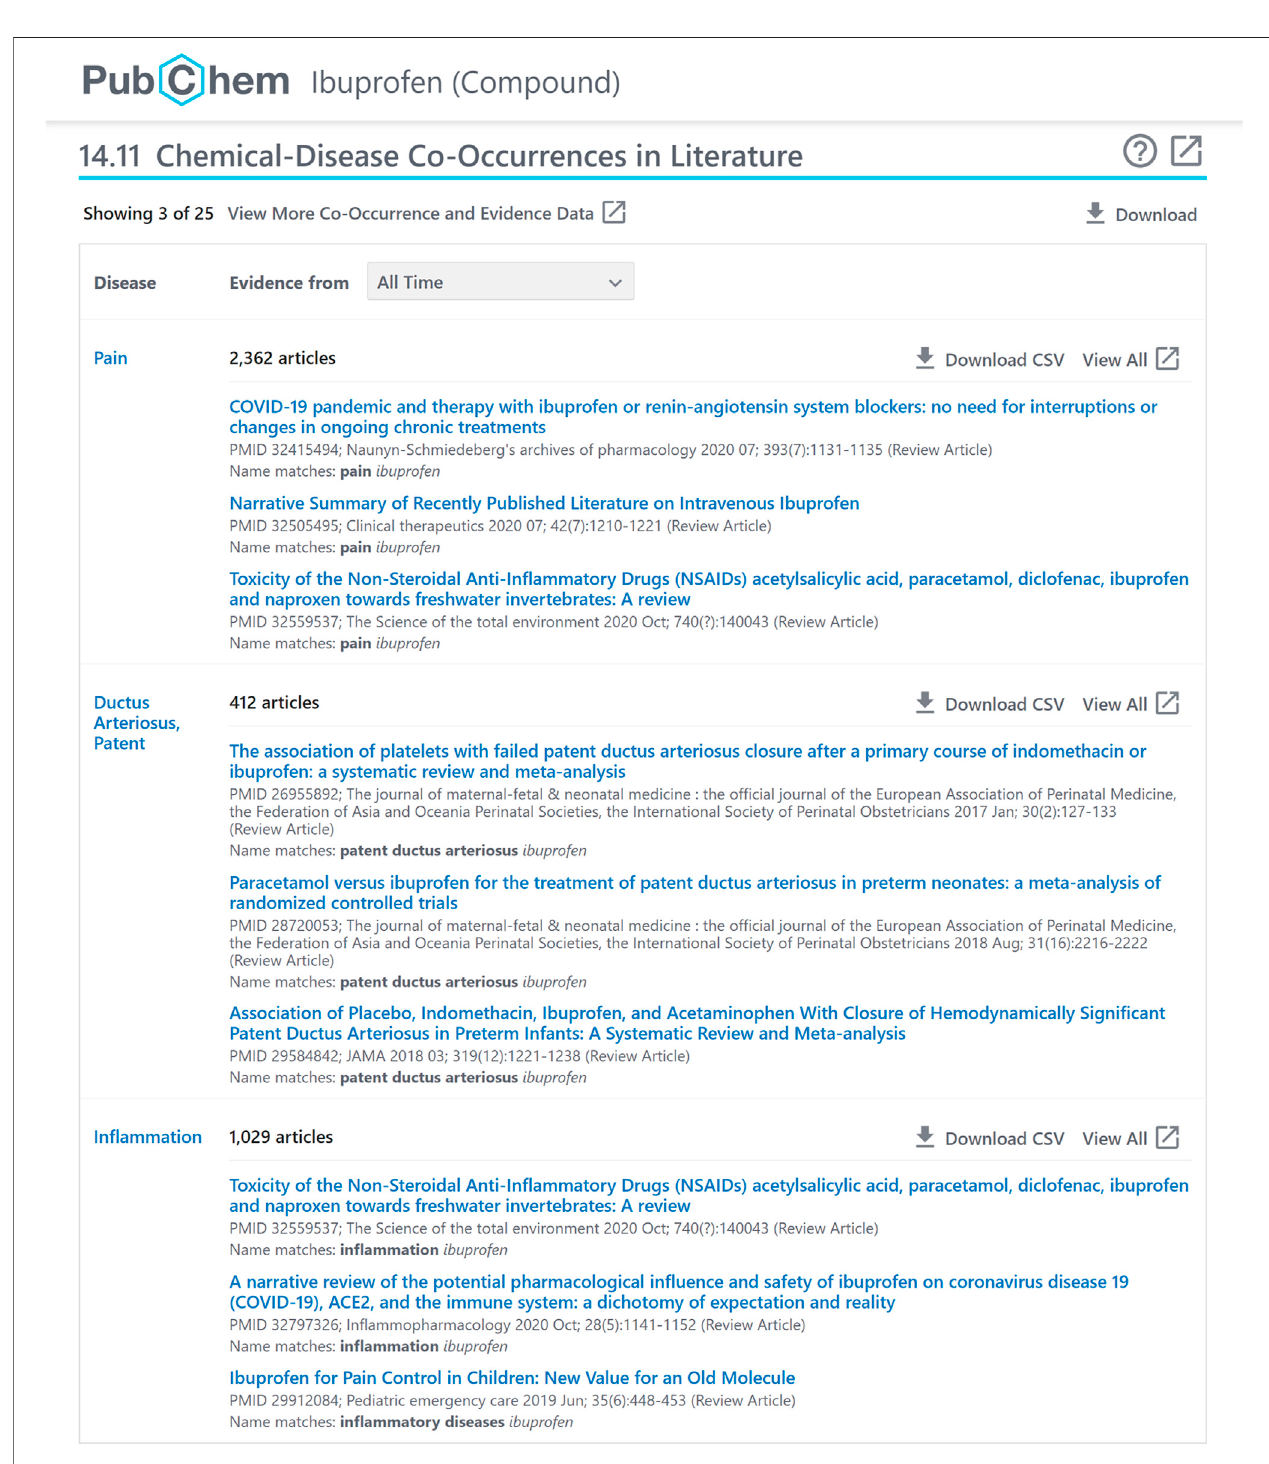
FIGURE 3 | A chemical-disease co-occurrence panel for ibuprofen (CID 3672), accessible at: https://pubchem.ncbi.nlm.nih.gov/compound/ 3672#section (cid:2) Chemical-Disease-Co-Occurrences-in-Literature.